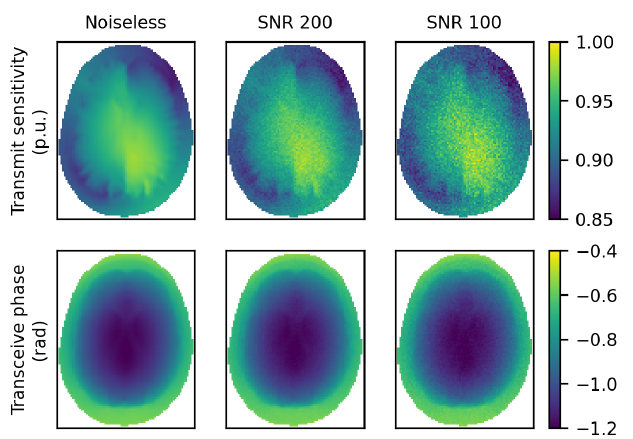
| (top) and TRx phase ϕ ± (bottom) 1